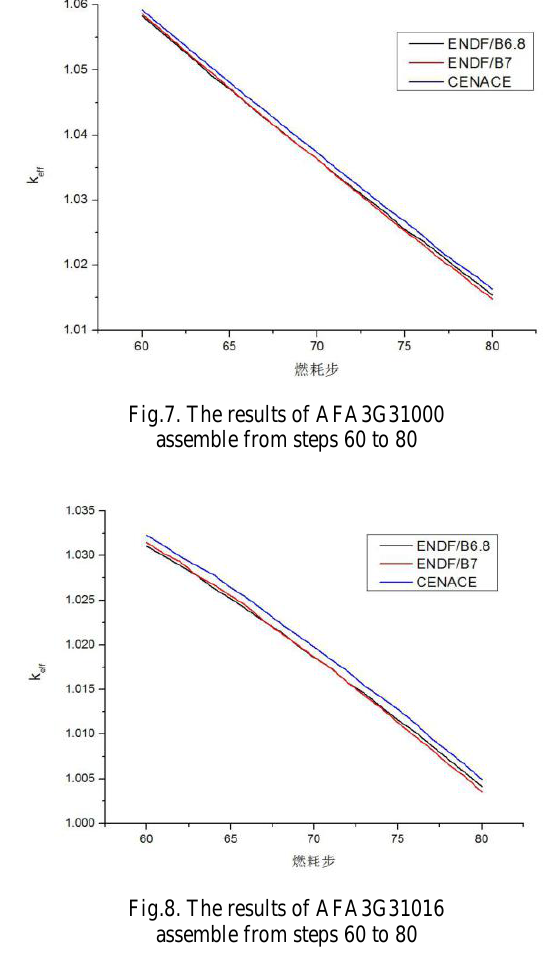
Fig.8. The results of AFA3G31016 assemble from steps 60 to 80 ENDF/B7 and ENDF/6.8 library is basically same, results of CENACE library is slightly higher than the ENDF/B7 and ENDF/6.8